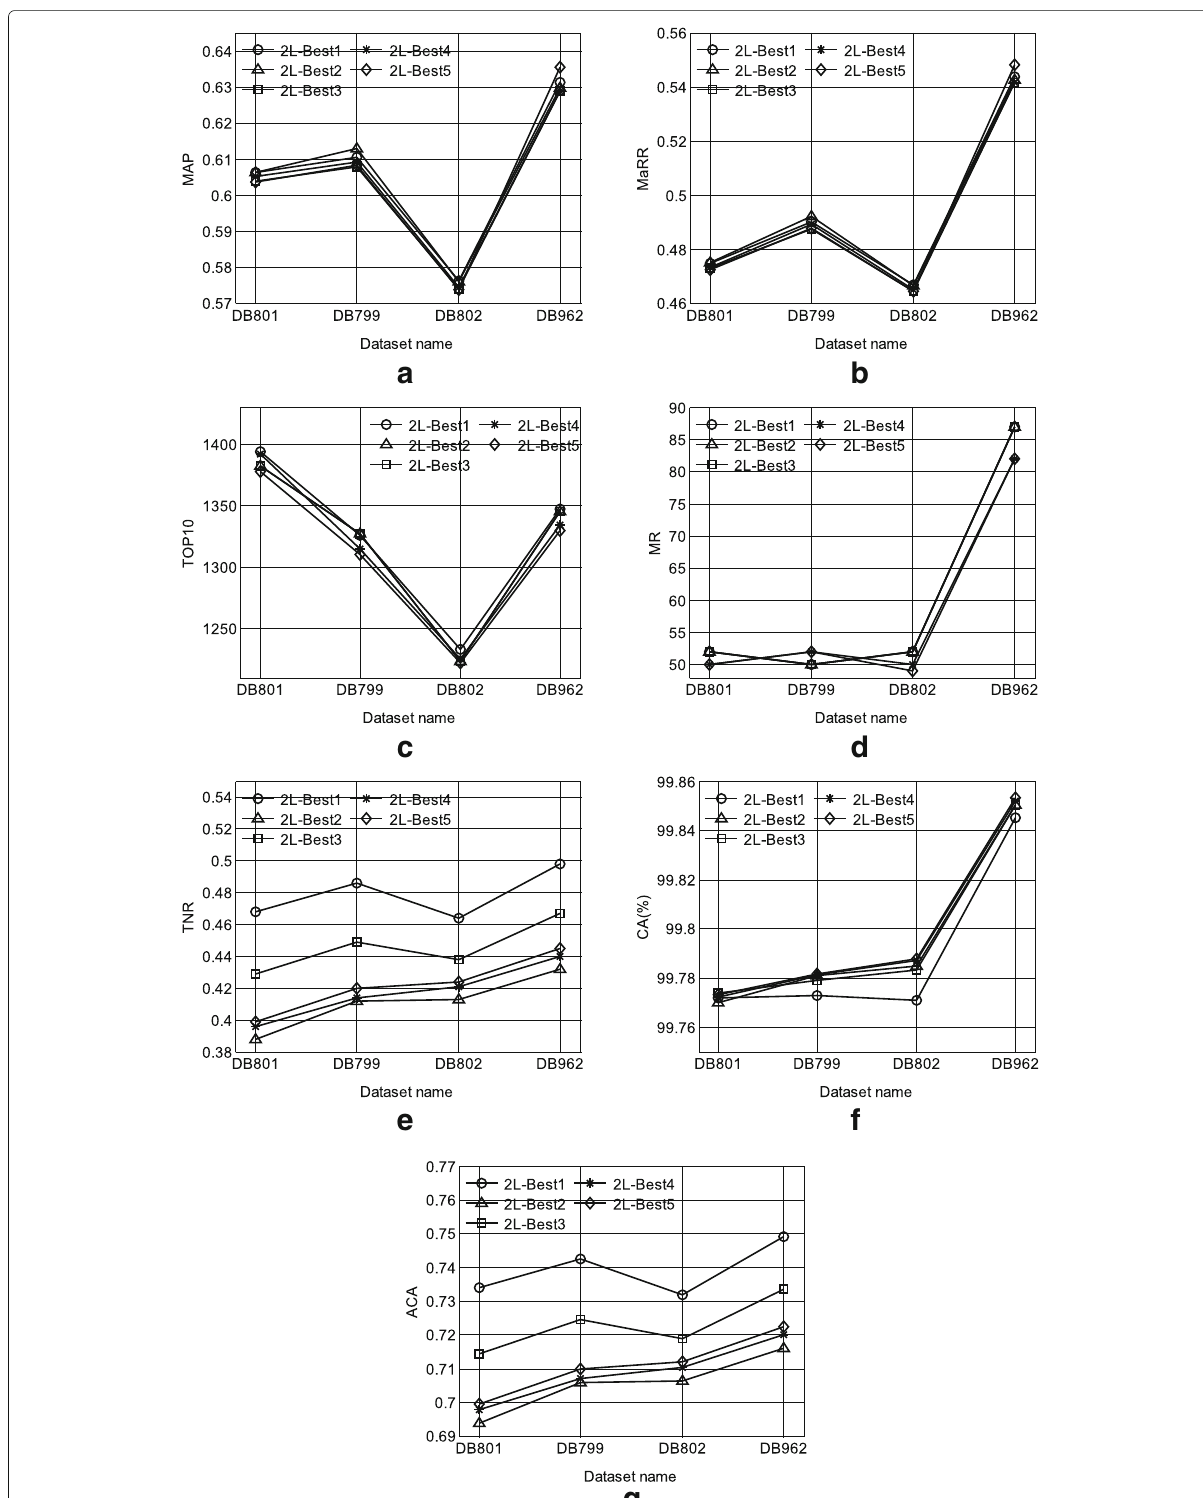
Fig. 7 Comparison of identification accuracy, in terms of a MAP, b MaRR, c TOP10, and d MeanRank, and classification efficiency, in terms of e TNR, f CA, and g ACA, obtained after late fusion based on different learning method combinations on different